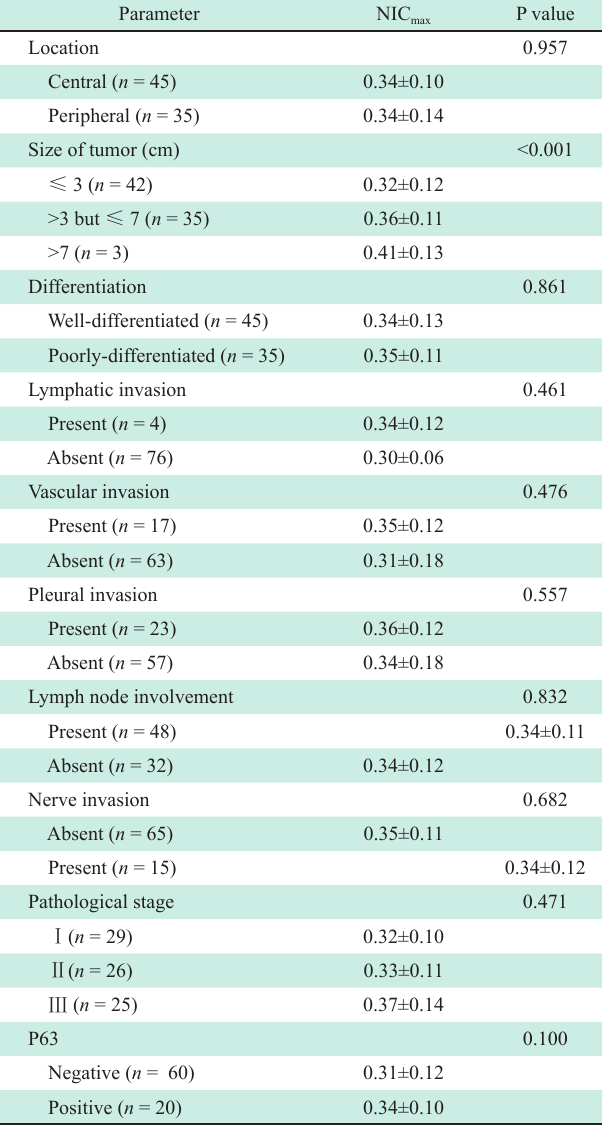
Table 4 Difference of GSI quantitative parameter of the SqCC with the correlation of pathological findings in 80 patients